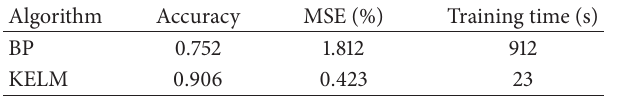
Table 1: Comparison of porosity prediction performance results on KELM against BP methodology for well YQ2. The comparison strata belong to the Shanxi group of the Permian formation.